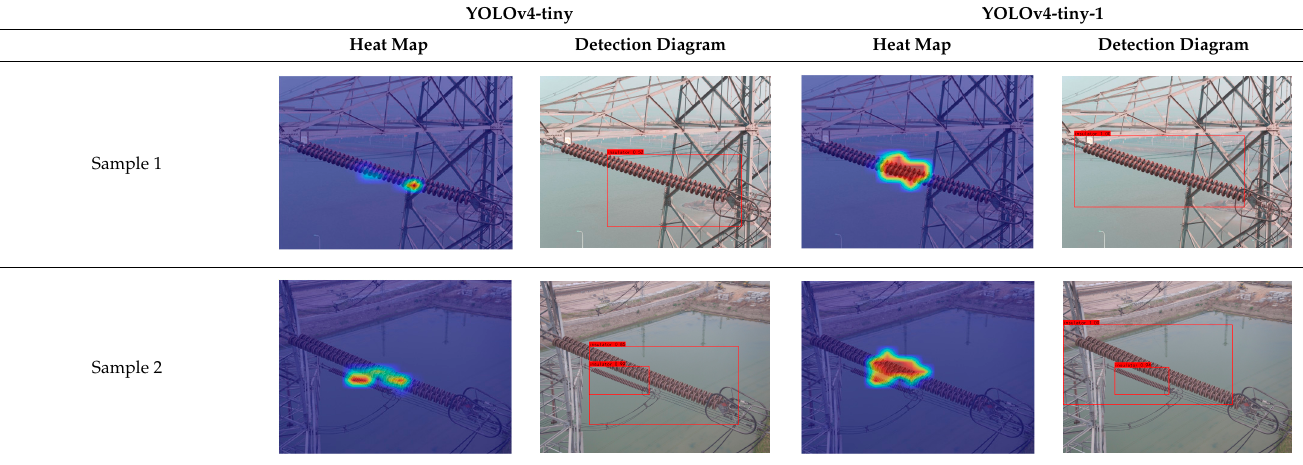
Table 7. Table 7. Table 7. Table 7. Table 7. Improvement comparison of the insulator positioning. Table 7. Improvement c omparison of the insulator positioning. Table 7. Improvement c omparison of the insulator positioning. Table 7. Improvement c omparison of the insulator positioning. Table 7. Improvement c omparison of the insulator positioning. Table 7. Improvement c omparison of the insulator positioning. Table 7. Improvement c omparison of the insulator positioning. Table 7. Improvement c omparison of the insulator positioning. Table 7. Improvement c omparison of the insulator positioning. YOLOv4-tiny Heat Map